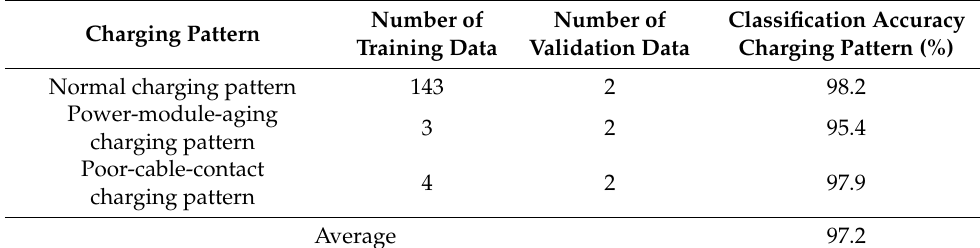
Table 4. Classification accuracy by type of fast-charging